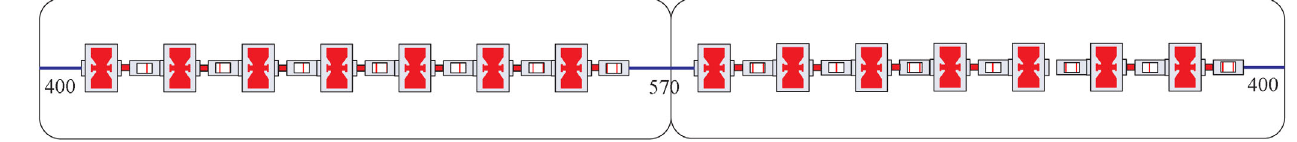
FIG. 12. Schematic of the two cryomodules layout of the Injector I SC section (unit: mm).